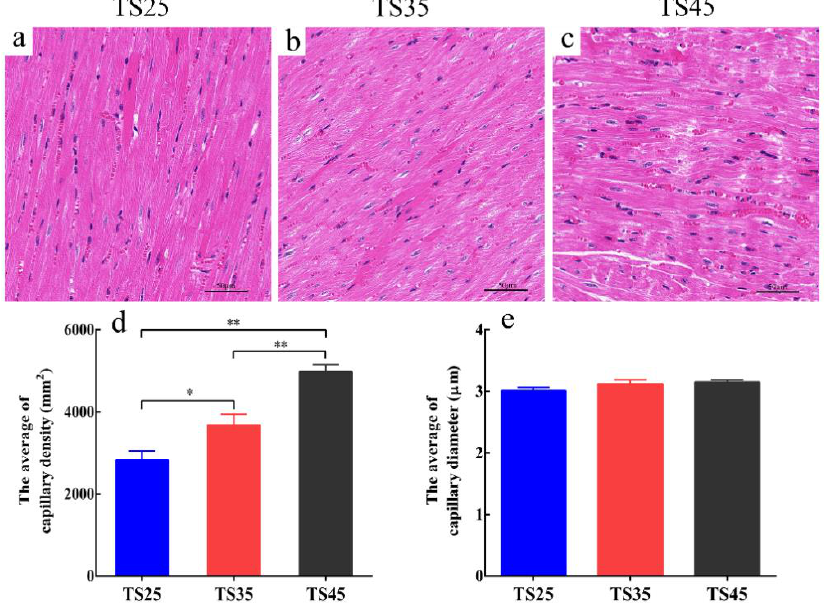
Figure 1. The morphological characteristics of the hearts in Tibetan sheep by H&E staining (40 × ). ( a – c ) Morphological characteristics of heart. ( d ) Capillary density per unit area. ( e ) Average diameter of single capillary per unit area. ( TS25 ) 2500 m altitude Tibetan sheep. ( TS35 ) 3500 m altitude Tibetan sheep. ( TS45 ) 4500 m altitude Tibetan sheep. Data shown on graph are means ± SEM. TS25 as control, * p < 0.05, ** p < 0.01.